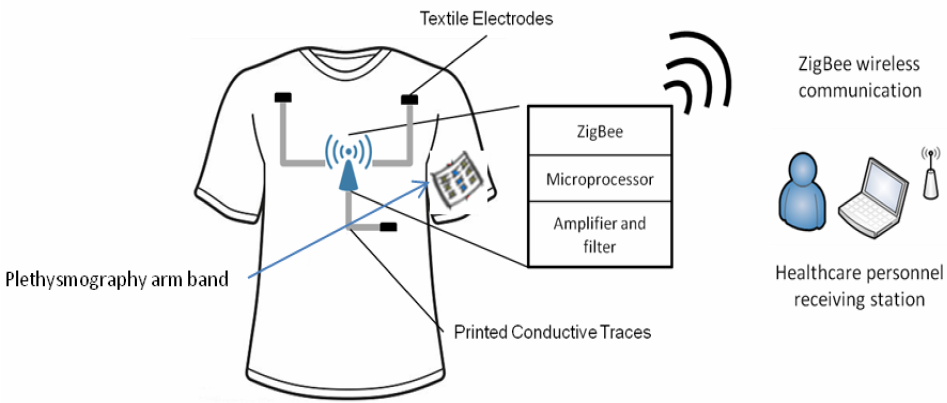
Figure 1. Schematic showing overall system for the acquisition of ECG through the e-bro.